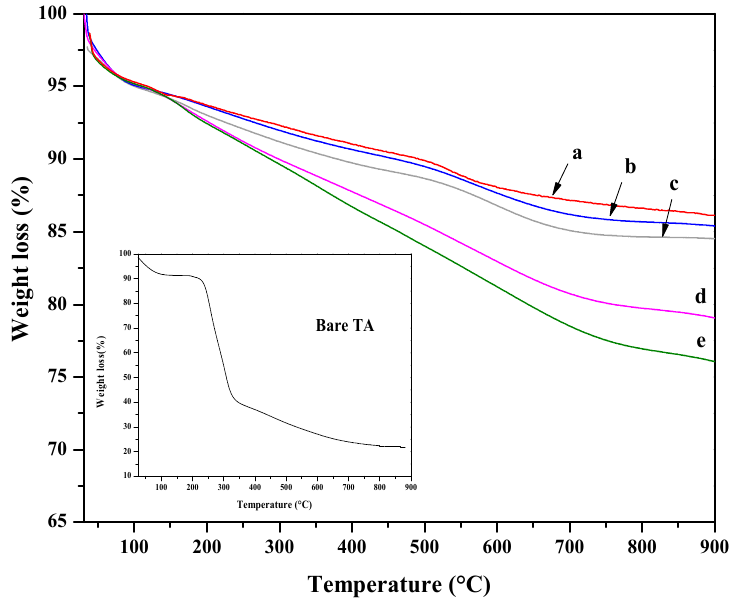
Figure 4. TGA curves of: SiO 2 (SiO 2 NPs) ( a ), 30TA-SiO 2 ( b ), 60TA-SiO 2 ( c ), 120TA-SiO 2 ( d ) and 150TA-SI ( e ) NPs. In the inset the TGA of bare TA is reported.